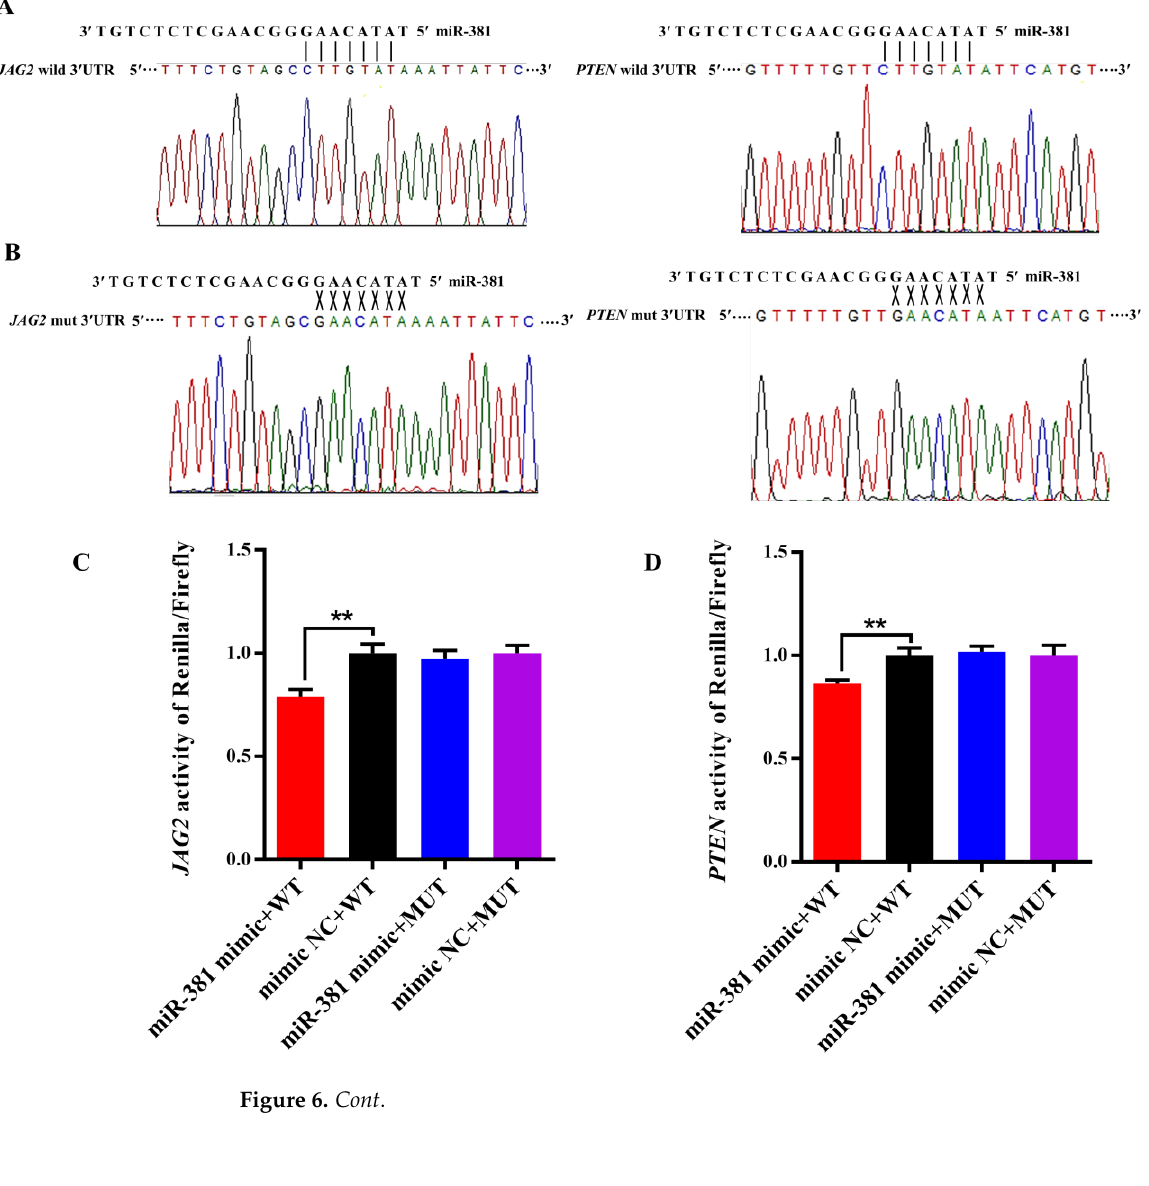
Figure 6. Validation of predicted target genes of miR-381 using dual luciferase reporter assay. ( A ) The binding sequences of miR- 381 with the 3′UTR of JAG2 and PTEN in wild-type dual luciferase reporter vectors. ( B ) The complementary sequences of the binding sequences in mutant-type dual